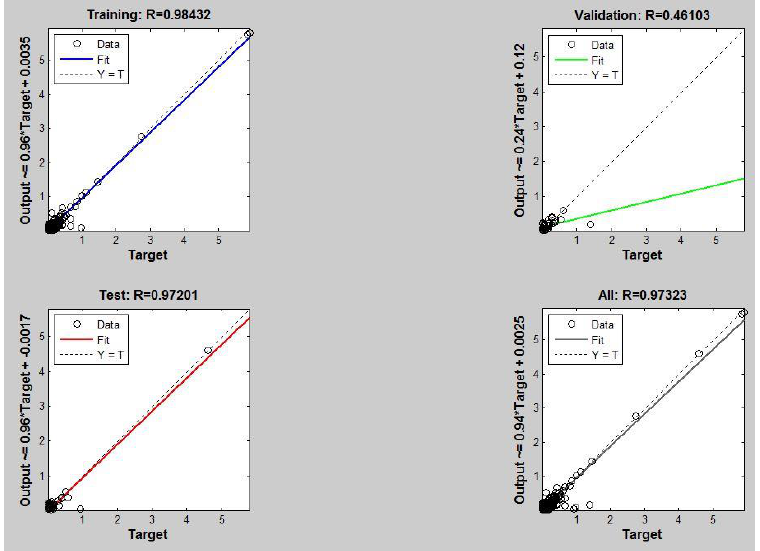
Figure 4. ANN (M 13.10.1 ) training regression performance plots of Perigiali